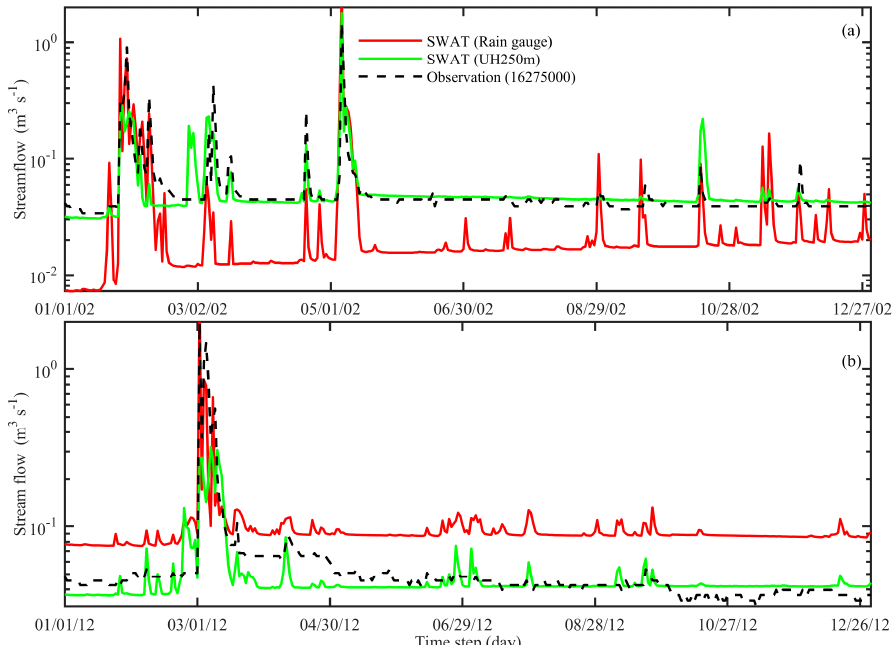
Figure 8. Effect of using nearby rain gauge and interpolated 250 m rainfall data on daily streamflow hydrographs of Heeia watershed at Haiku during calibration ( a ) and validation ( b ) periods. Daily observed and simulated flows are only shown for one-year period.